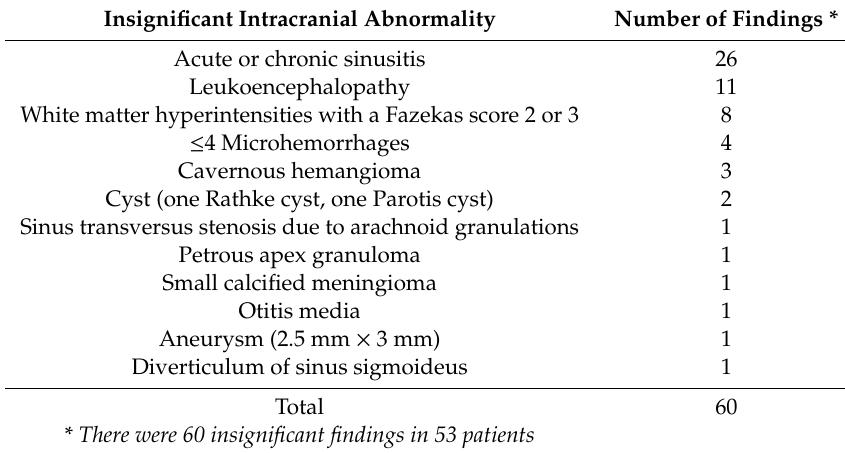
Table A2. Insignificant intracranial